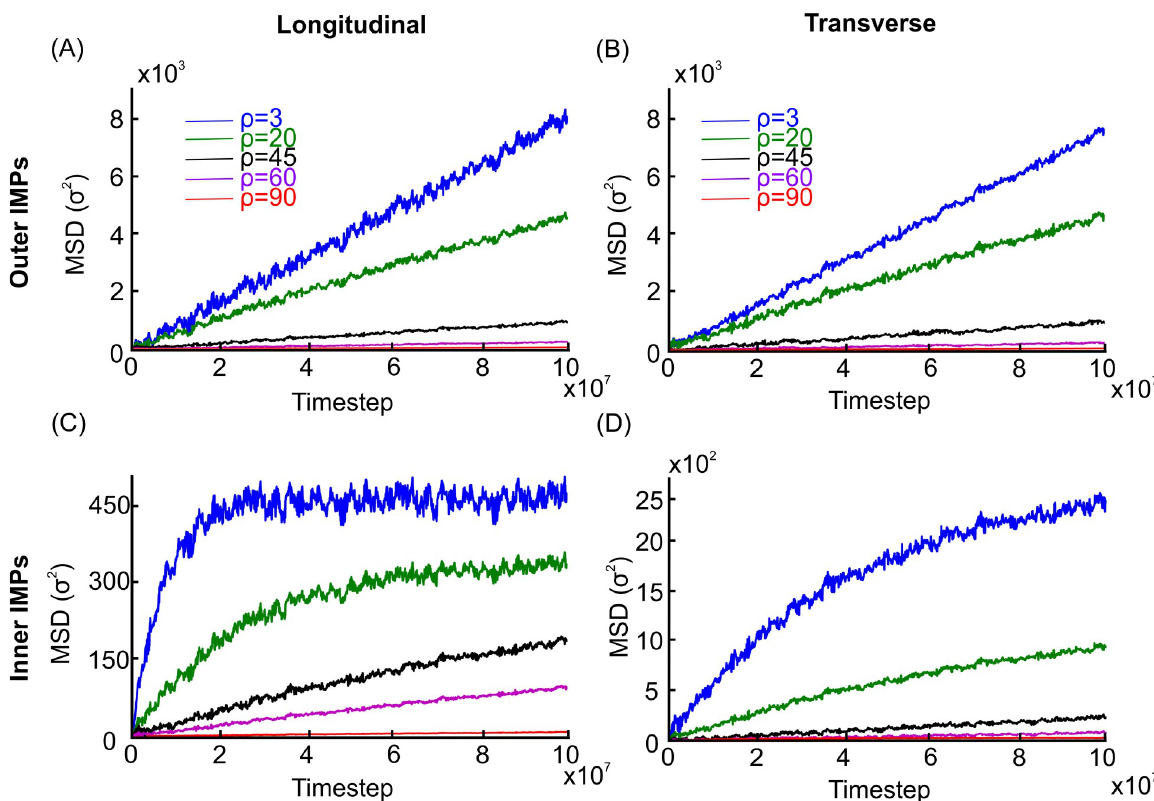
Fig 7. One-dimensional MSDs of IMPs at different accumulation levels of anchored TMP. (A). Longitudinal and (B). Transverse MSDs of IMPs of the outer leaflet at 3, 20, 45, 60 and 90 pprc. (C). Longitudinal and (D). Transverse MSDs of IMPs of the inner leaflet at 3, 20, 45, 60 and 90 pprc. The percentages of surface area coverage are 0.87%, 5.83%, 13.11%, 17.48%, and 26.22%,